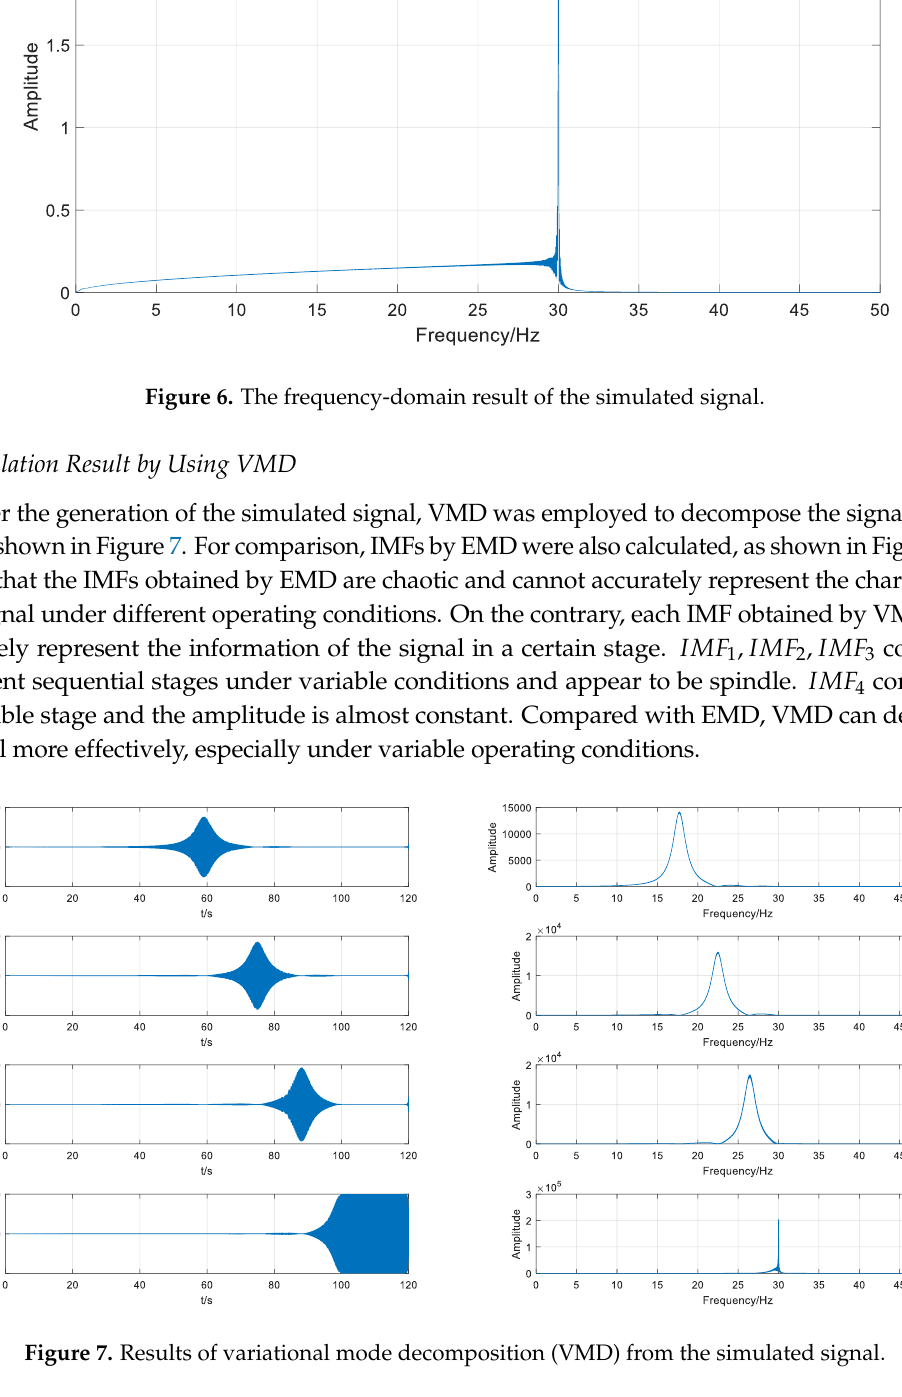
Figure 5. The generated simulated signal.